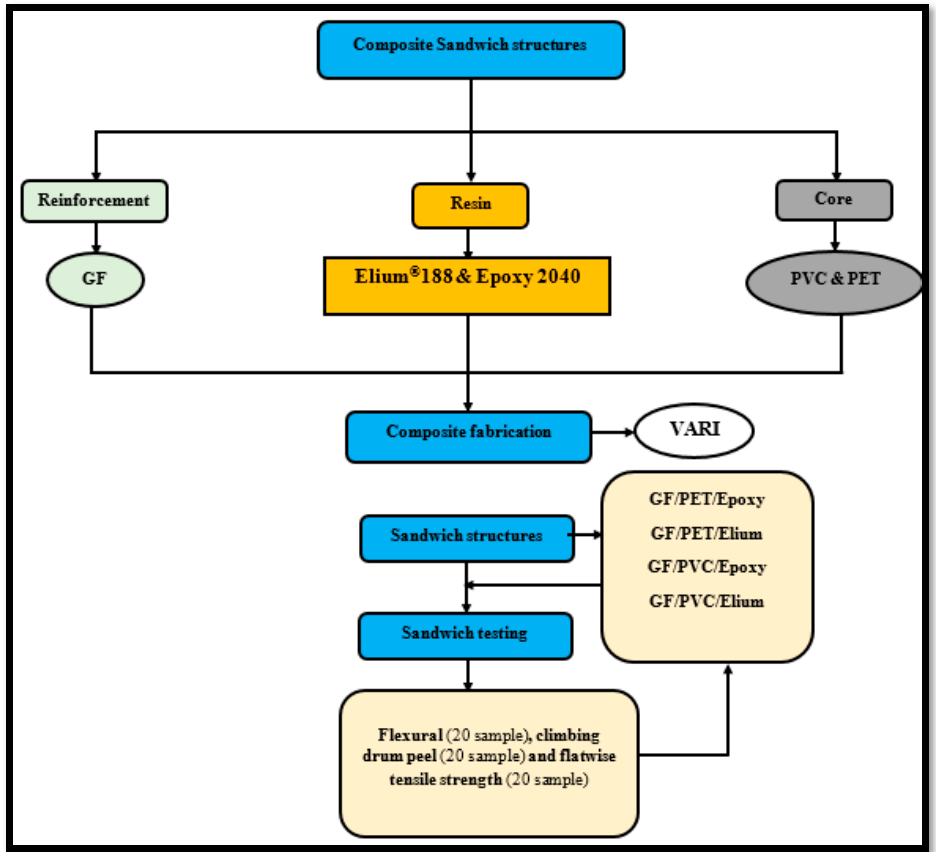
Figure 4. flowchart of composite sandwich structures methodology and testing. Figure 4. Flowchart of composite sandwich structures methodology and